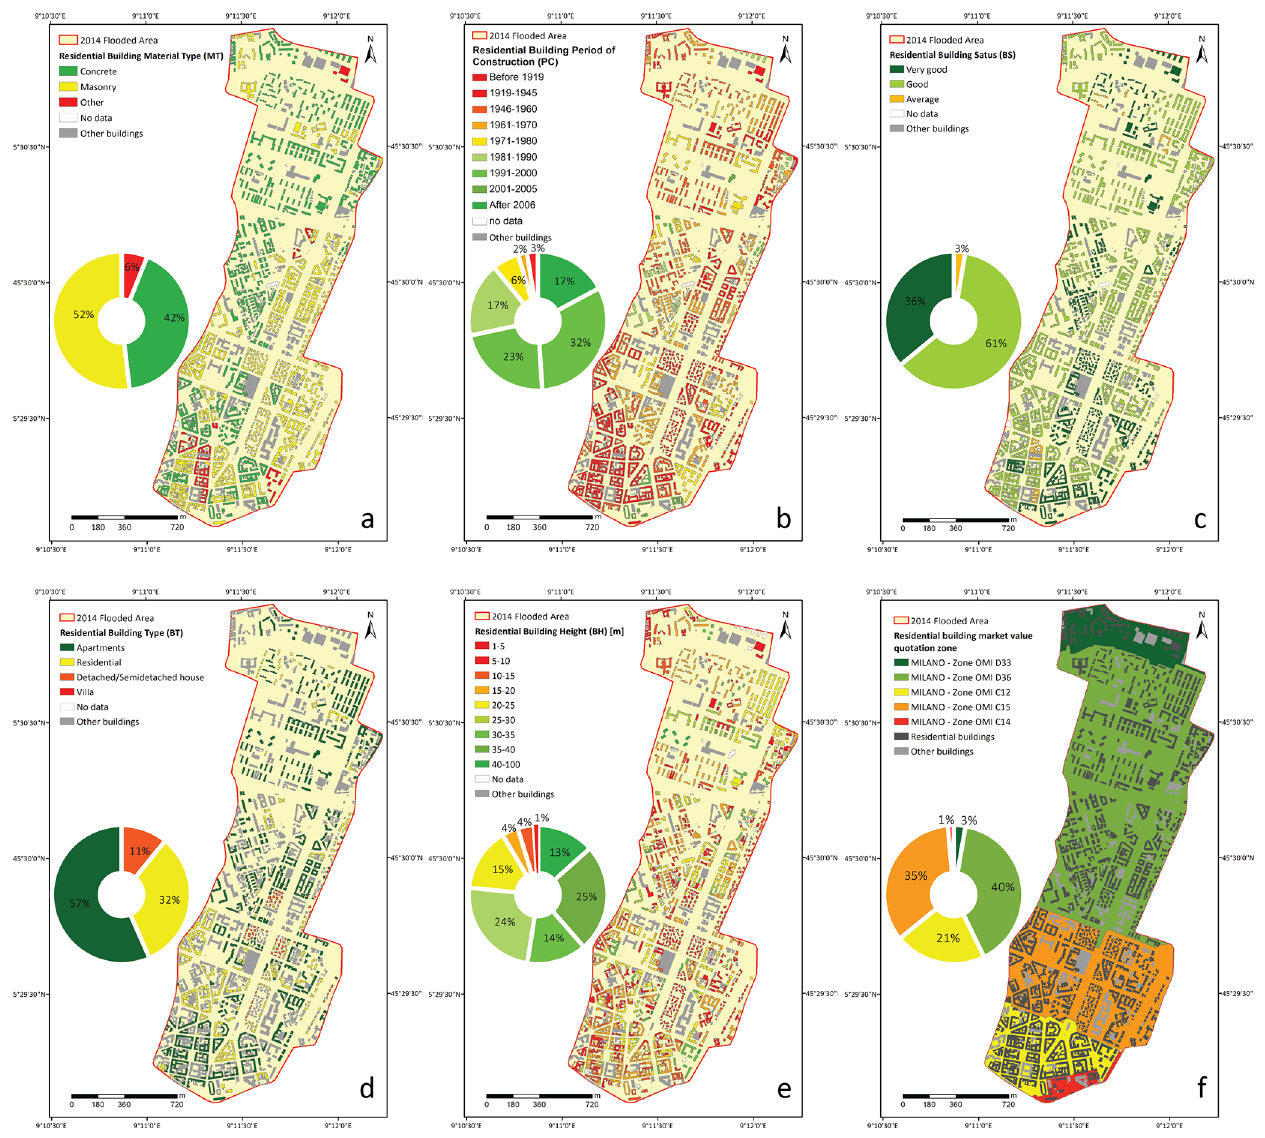
Figure 6. Residential Buildings: (a) material type map (MT); (b) period of construction map (PC); (c) building status (BS) map; (d) building type map (BT); (e) building height map (BH); (f) OMI zone map according to the National Real Estate Observatory (OMI) classification based on territory sub-division (central and semi-central urban, suburban, peri-urban, and peripheral areas) having higher market value quotations (increasing from red to green). Pie charts represent the percentages of residential building distribution according to structural and non-structural features. Built-up-area shapefile is from © OpenStreetMap contributors 2022. Distributed under the Open Data Commons